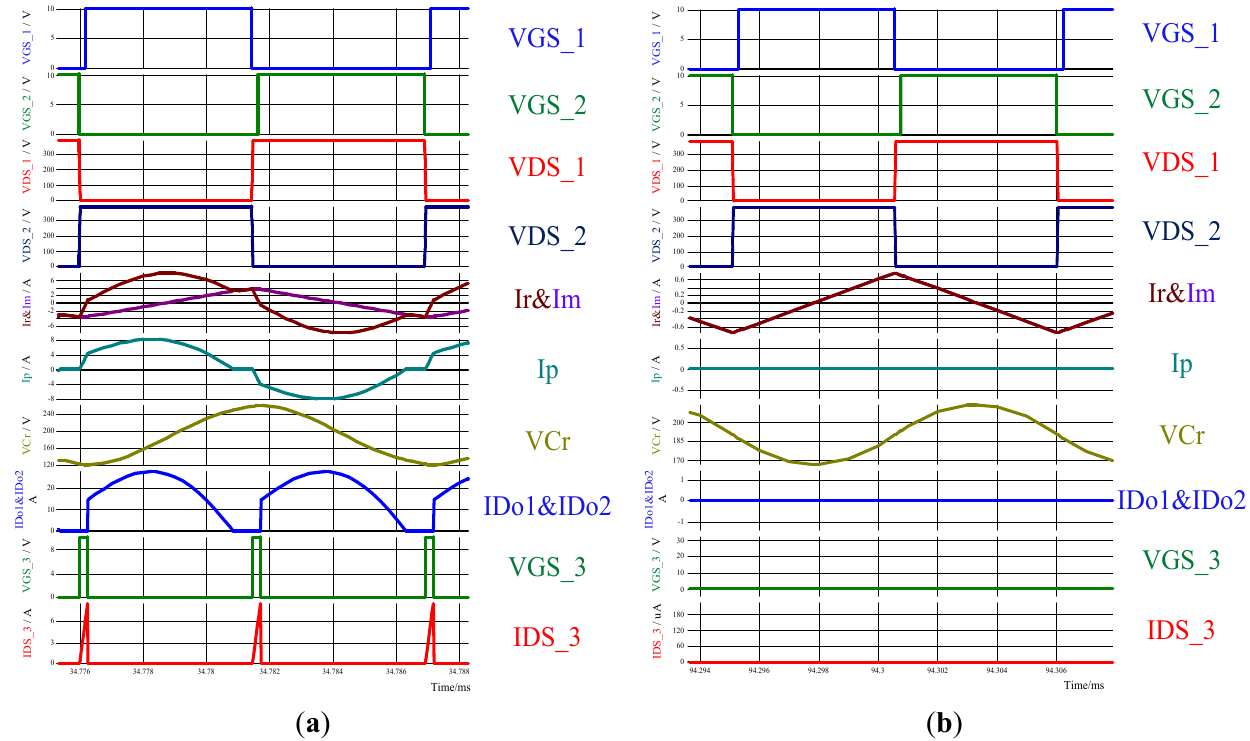
Figure 23. Simulation waveforms for novel LLC control circuit at 480 W/48 V: ( a ) 100% load; and ( b ) 0% load.